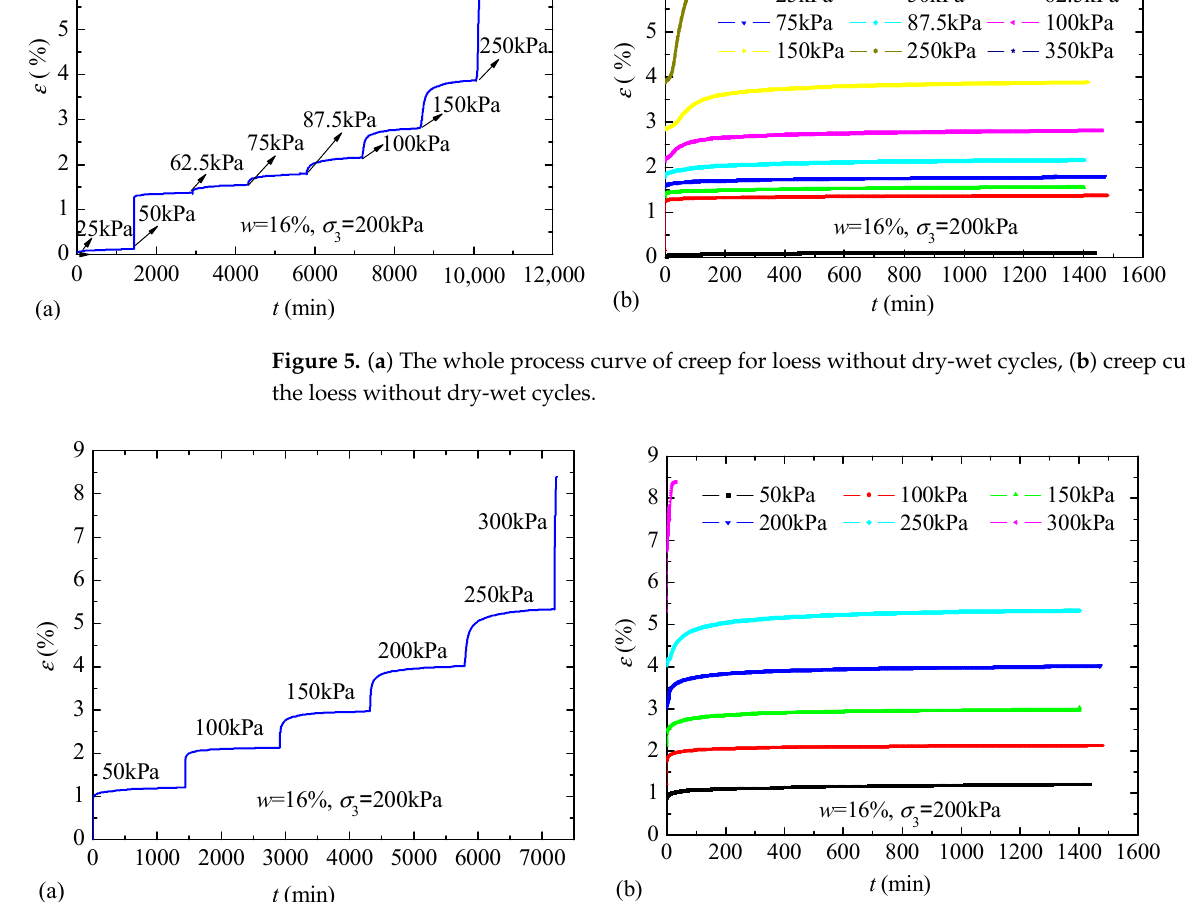
t (min) Figure 7. ( a ) The whole process curve of creep for loess with 10 dry-wet cycles, ( b ) creep curves of loess with 10 dry-wet cycles. w =16%, σ 3 = 200kPa 0